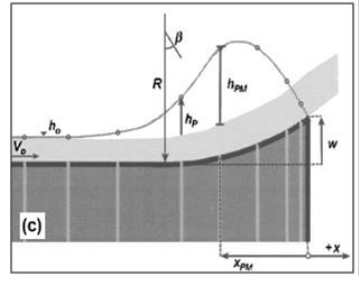
Figure 4. Static and dynamic pressure caused by free jet on the bucket